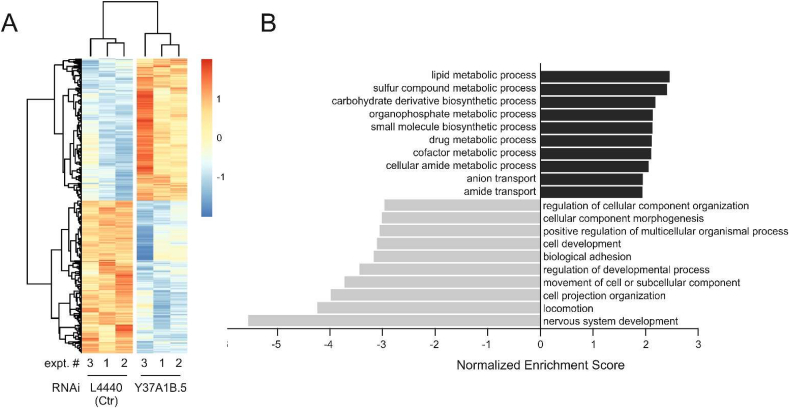
RNA-Seq analysis of transcriptome changes induced by Y37A1B.5 knockdown. (A) Heat map of individual expression values of all 2474 differentially expressed genes (adjusted p-value < 0.05). Prior to heat map calculation, raw read counts were size-factor normalized (DESeq2, v. 1.16.1). The color scale represents row z-score. Hierarchical clustering of the samples or DEGs is represented by dendrograms at the top and left, respectively. (B) GSEA analysis for GO biological processes using WebGestalt 2019, with fold changes of differentially expressed genes indicated as rank. Analysis was performed using standard settings. Black (positive) or gray (negative) bars show “up-” or “downregulated” GO terms according to normalized enrichment scores.